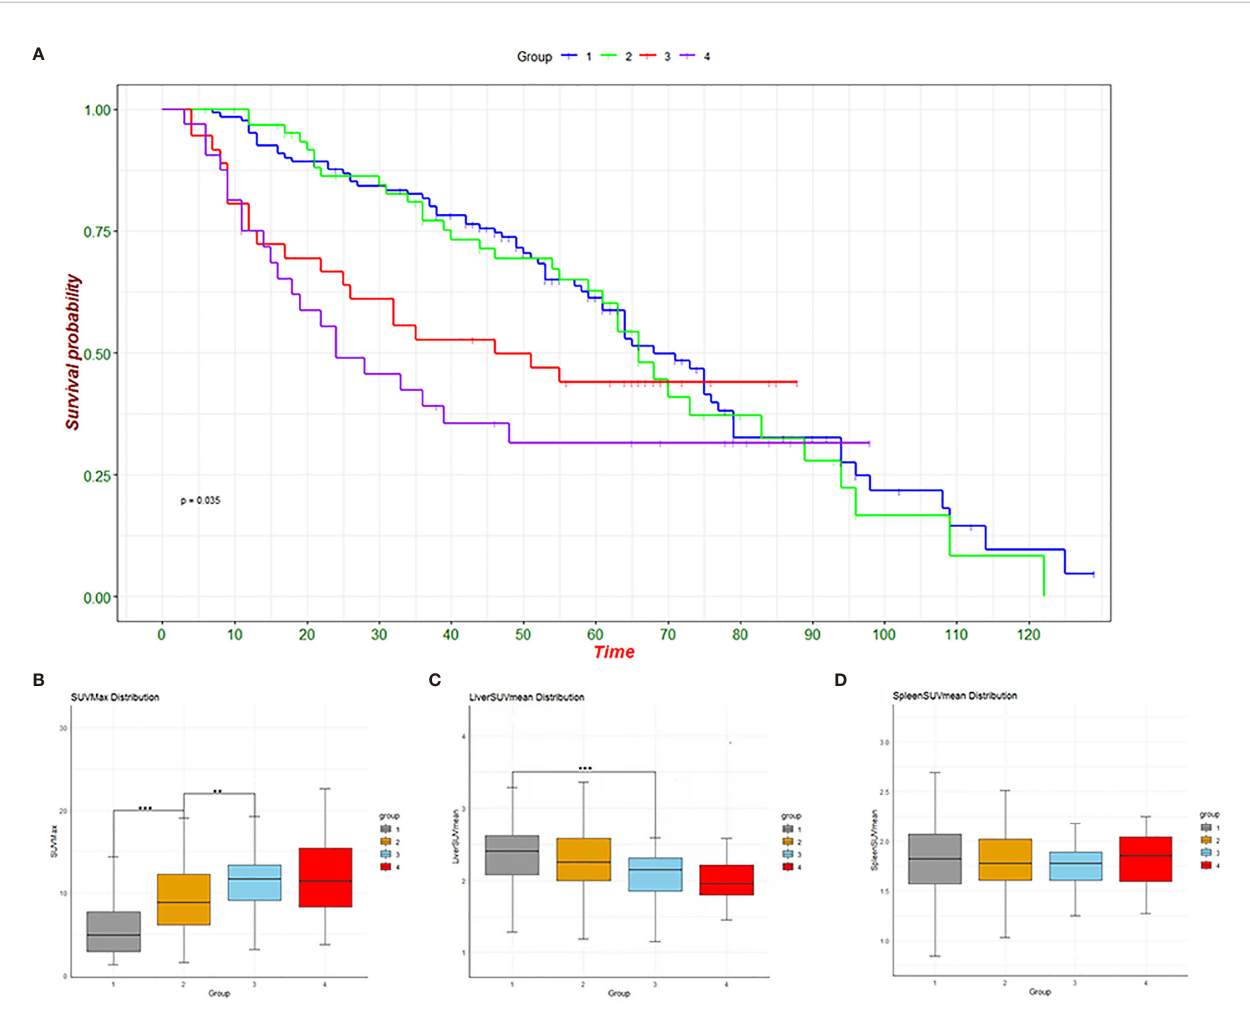
FIGURE 2 | Survival graphs of the four groups (A) and change trend graphs of SUVmax (B) , liver SUVmean (C) and spleen SUVmean (D) . **p < 0.01, ***p <